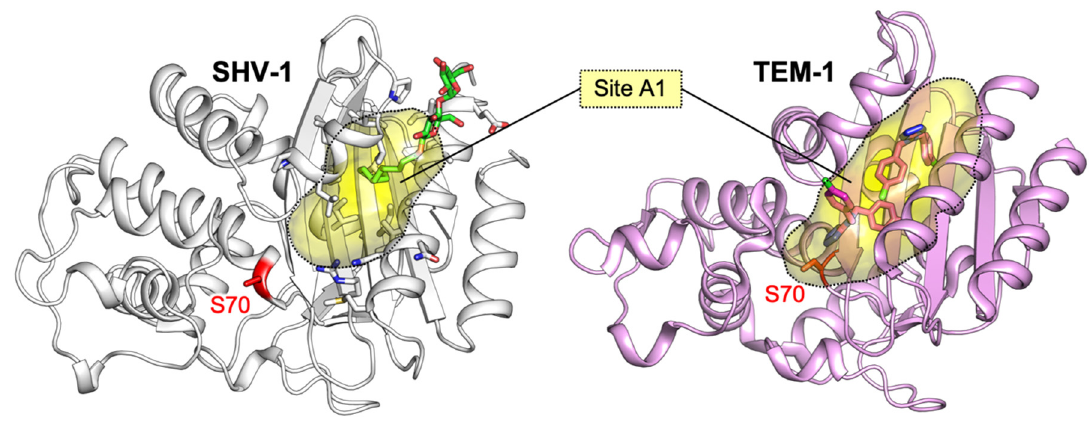
Figure 4. Allosteric site A1 in SHV-1 (gray, PDB ID: 1shv) and TEM-1 (pink, PDB ID: 1pzo) class A BLs.